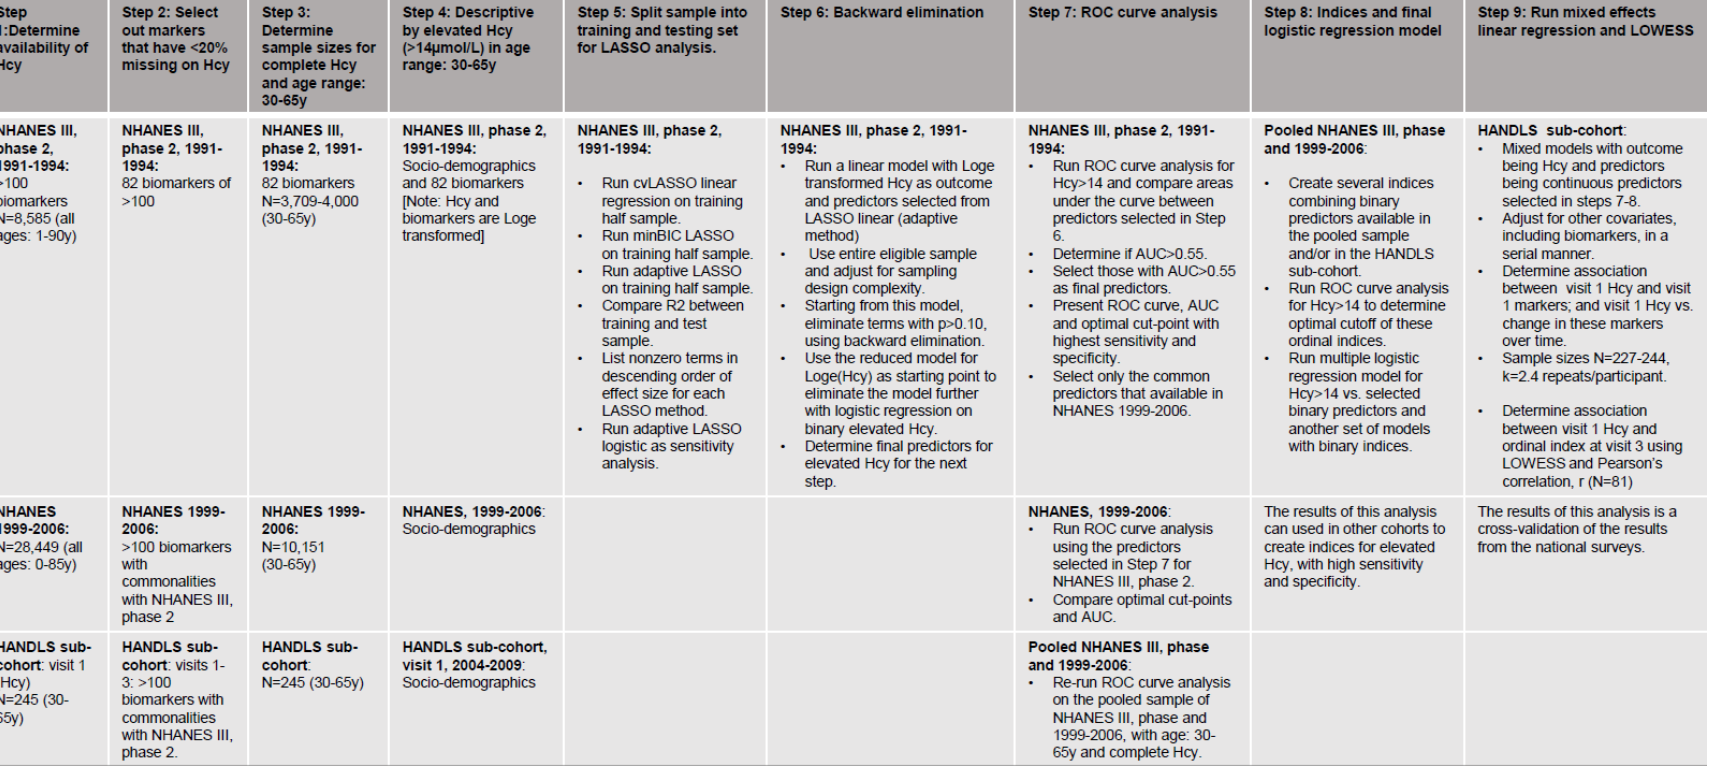
Figure 1. Flow diagram of predictive modeling using LASSO, ROC curves and multivariable regression modeling. Abbreviations: cvLASSO = cross-validation LASSO; LASSO = least absolute shrinkage and selection operator; LOWESS = Locally weighted regression; HANDLS = Healthy Aging in Neighborhoods of Diversity Across the Life Span; minBIC LASSO = minimum Bayesian information criterion LASSO; NHANES = National Health and Nutrition Examination Surveys; R2 = coefficient of determination.